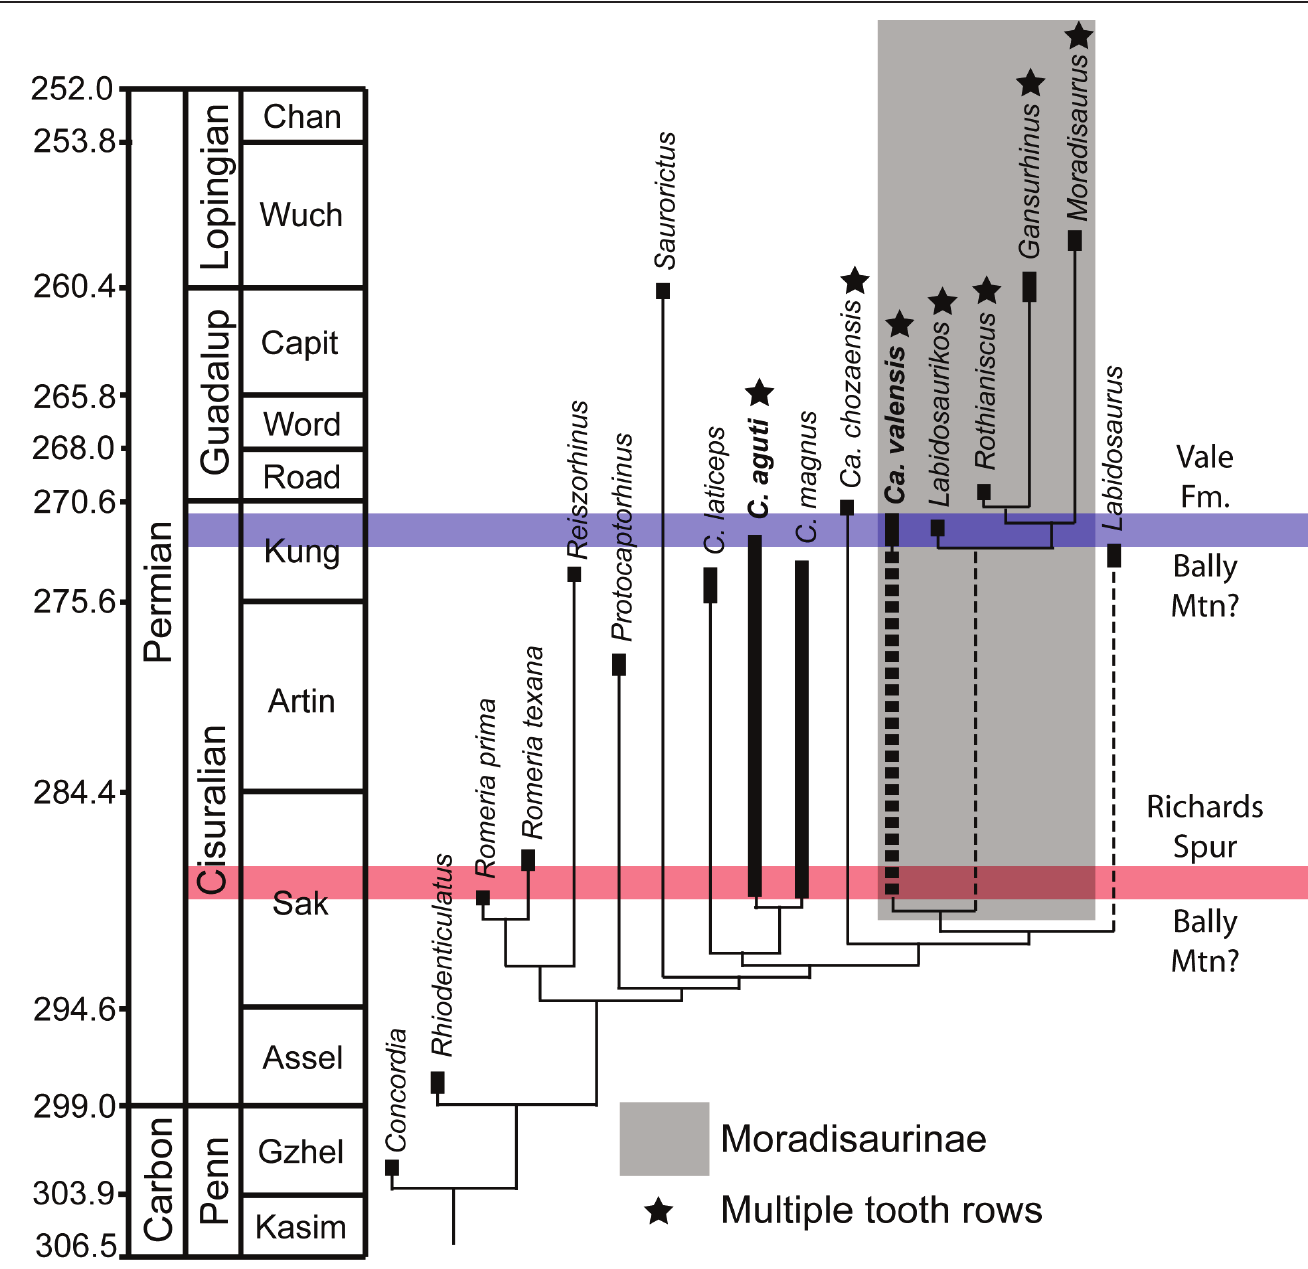
Figure 8. Time-calibrated phylogeny of Captorhinidae showing potential changes to temporal range of Captorhinikos valensis and related ghost lineages based on Bally Mountain material. Blue bar represents the potential chronostratigraphic position of Bally Mountain if it is time-equivalent to the Vale Formation of Texas. Red bar represents the position of Bally Mountain if it is time-equivalent to the Richards Spur locality in